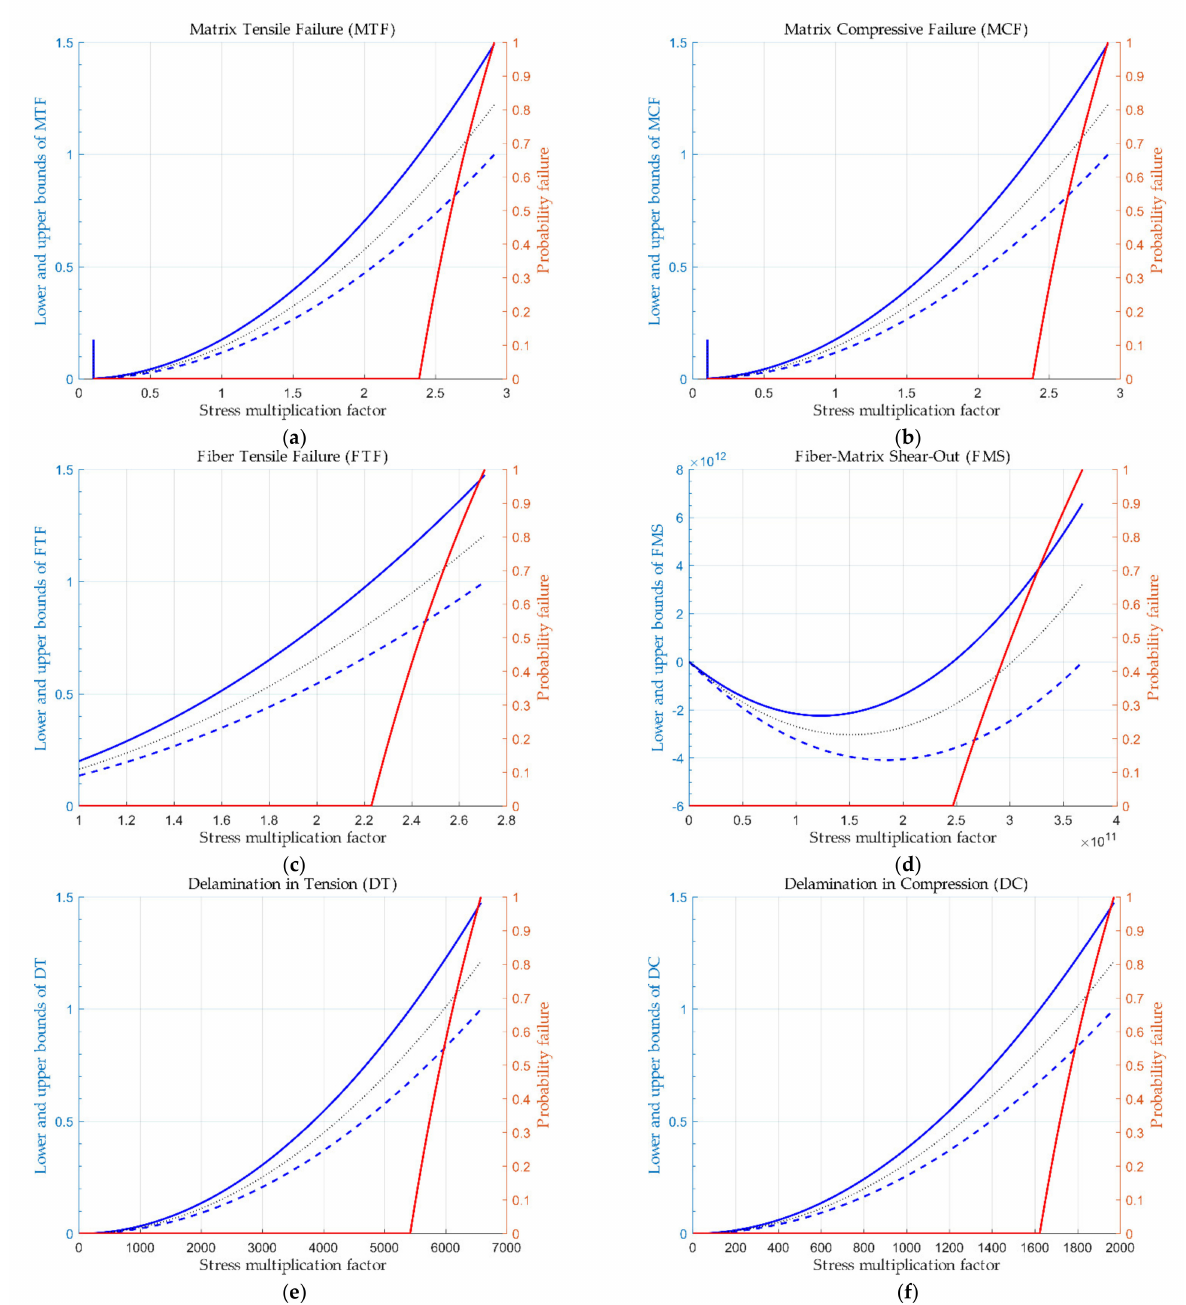
Figure 5. Plots of the upper and lower bounds, the nominal value of failure criteria, and the probability of failure regarding the stress multiplication factor for the 21xK43-LY556 UD